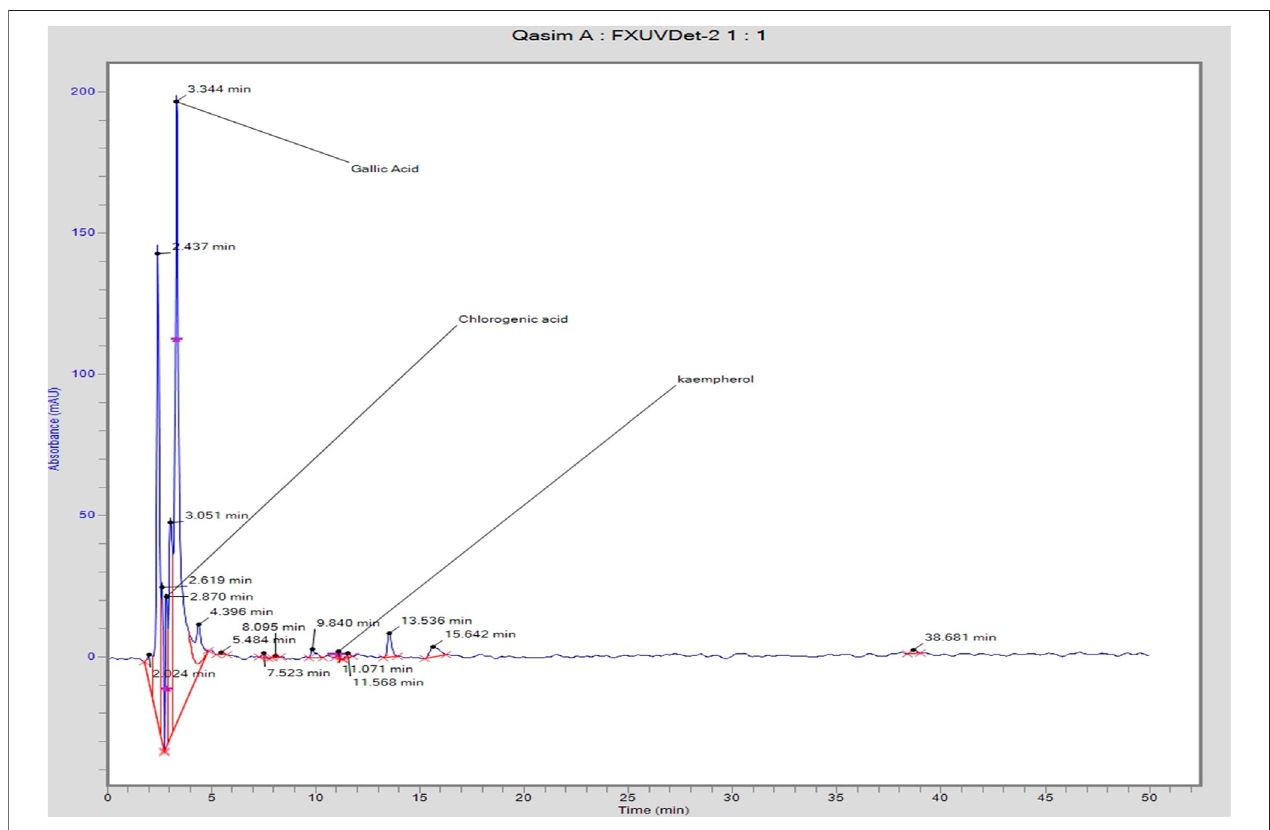
FIGURE 4 | HPLC pro fi le of N. sativa seed extract.